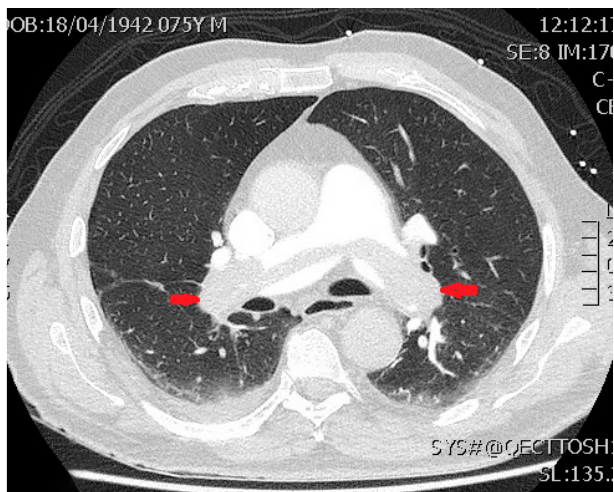
Fig. 1 - Computed tomography of pulmonary artery (axial view). Arrows show saddle pulmonary embolus obliterating bilateral pulmonary inflow.